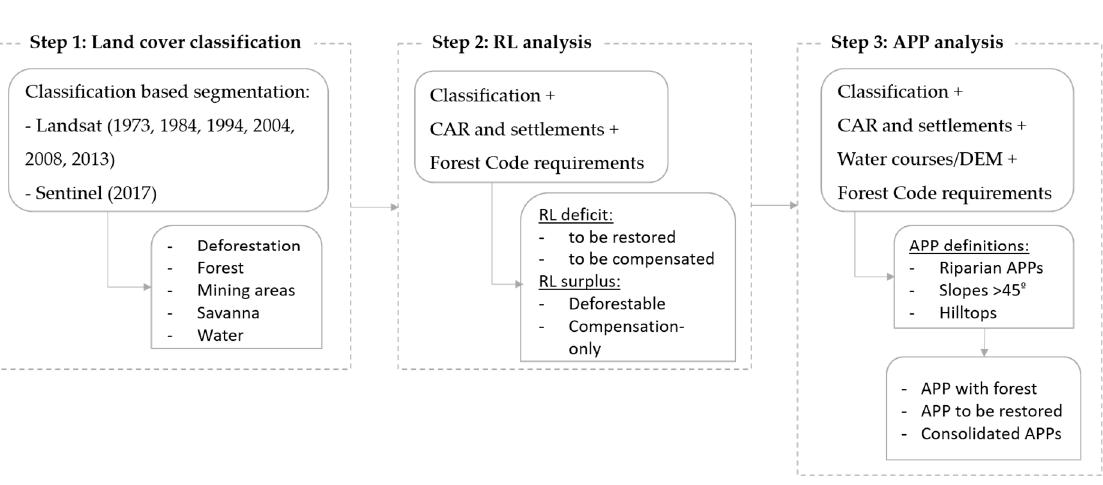
Figure 3. Summary of the methodology applied to evaluate APPs and RL across Itacaiúnas watershed. CAR is the Environmental Rural Property Registry; RL is Legal Reserve; DEM is the Digital Elevation Model from ALOS PALSAR; and APP is Permanent Preservation Area.